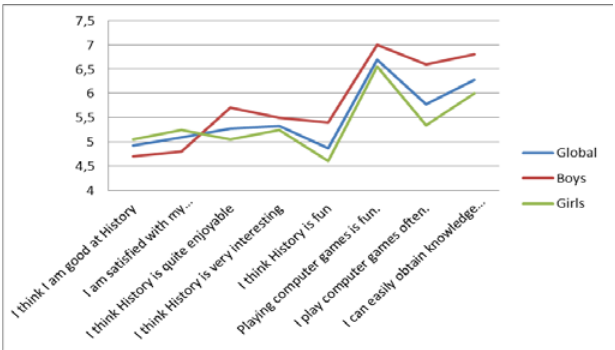
Figure 8. Comparison of pre and post